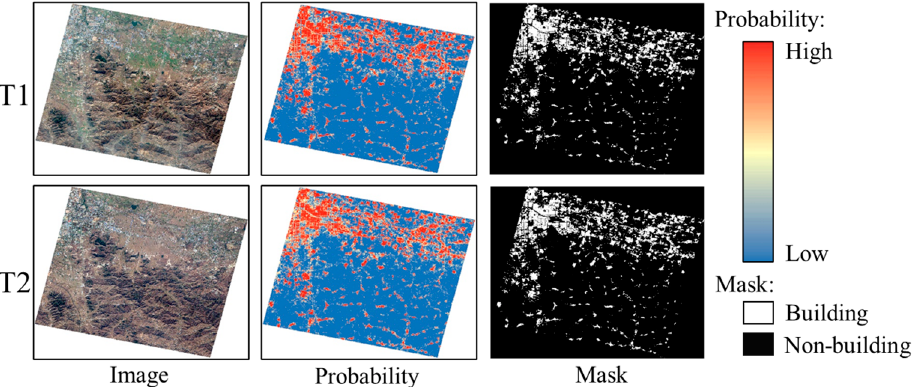
Figure 6. Results of building probability and mask of bi-temporal images ( T1 ) and ( T2 ) for group 1. Prob is linearly stretched from (0,1) to (0,250) for better illustration.